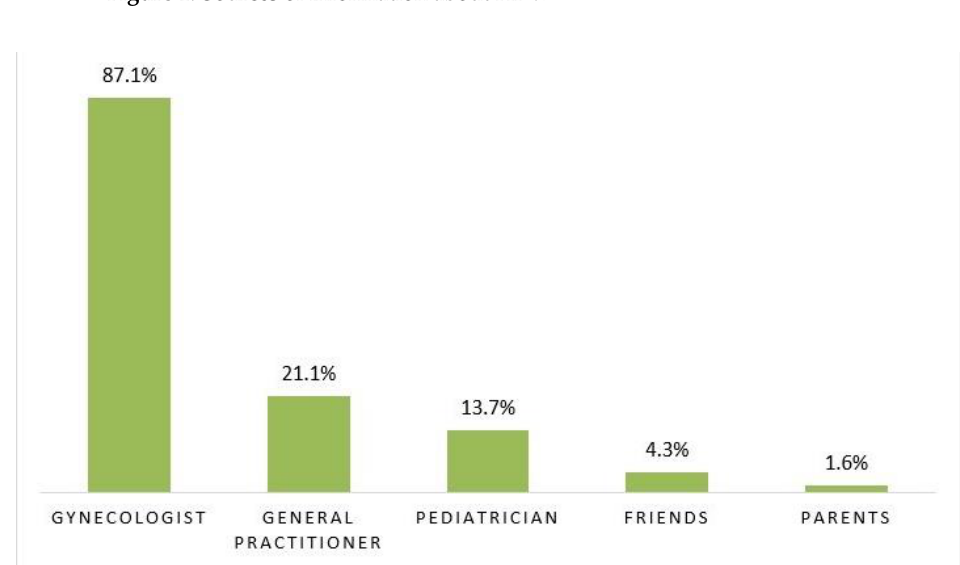
Figure 1. Sources of information about HPV.